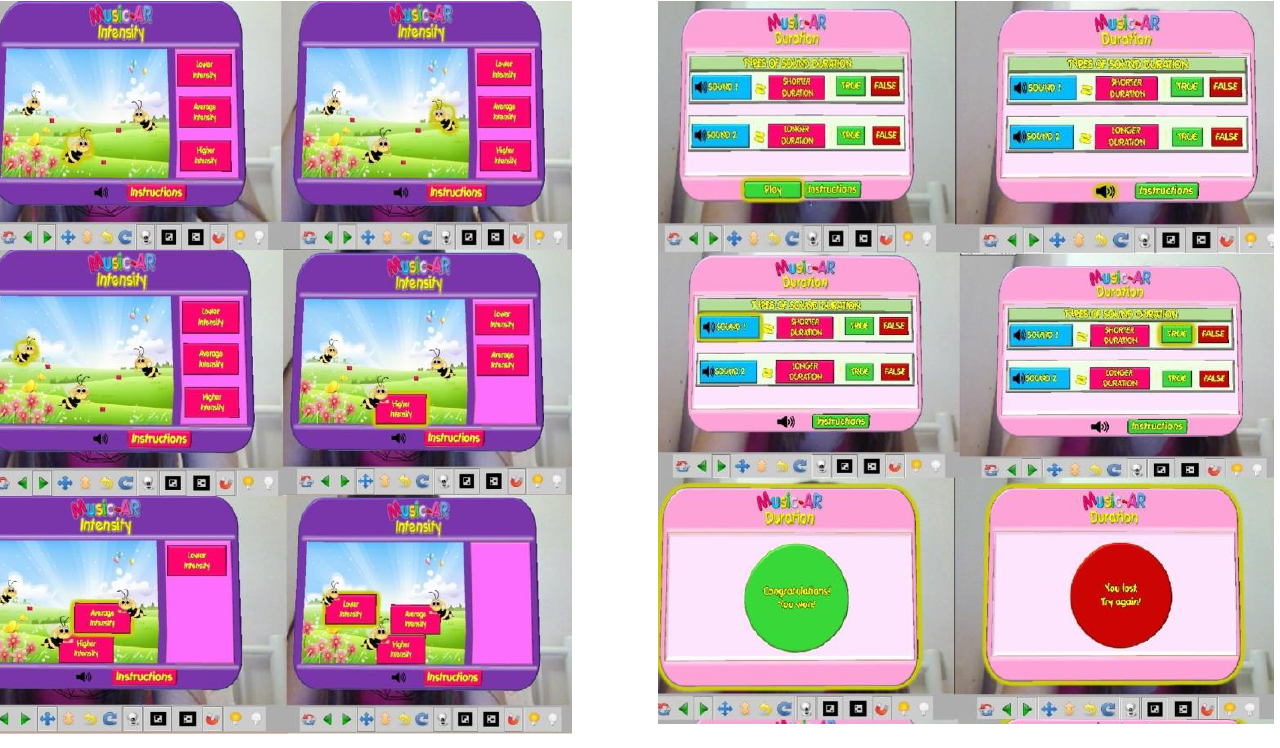
Figure 4. Main screens running the game on the Intensity